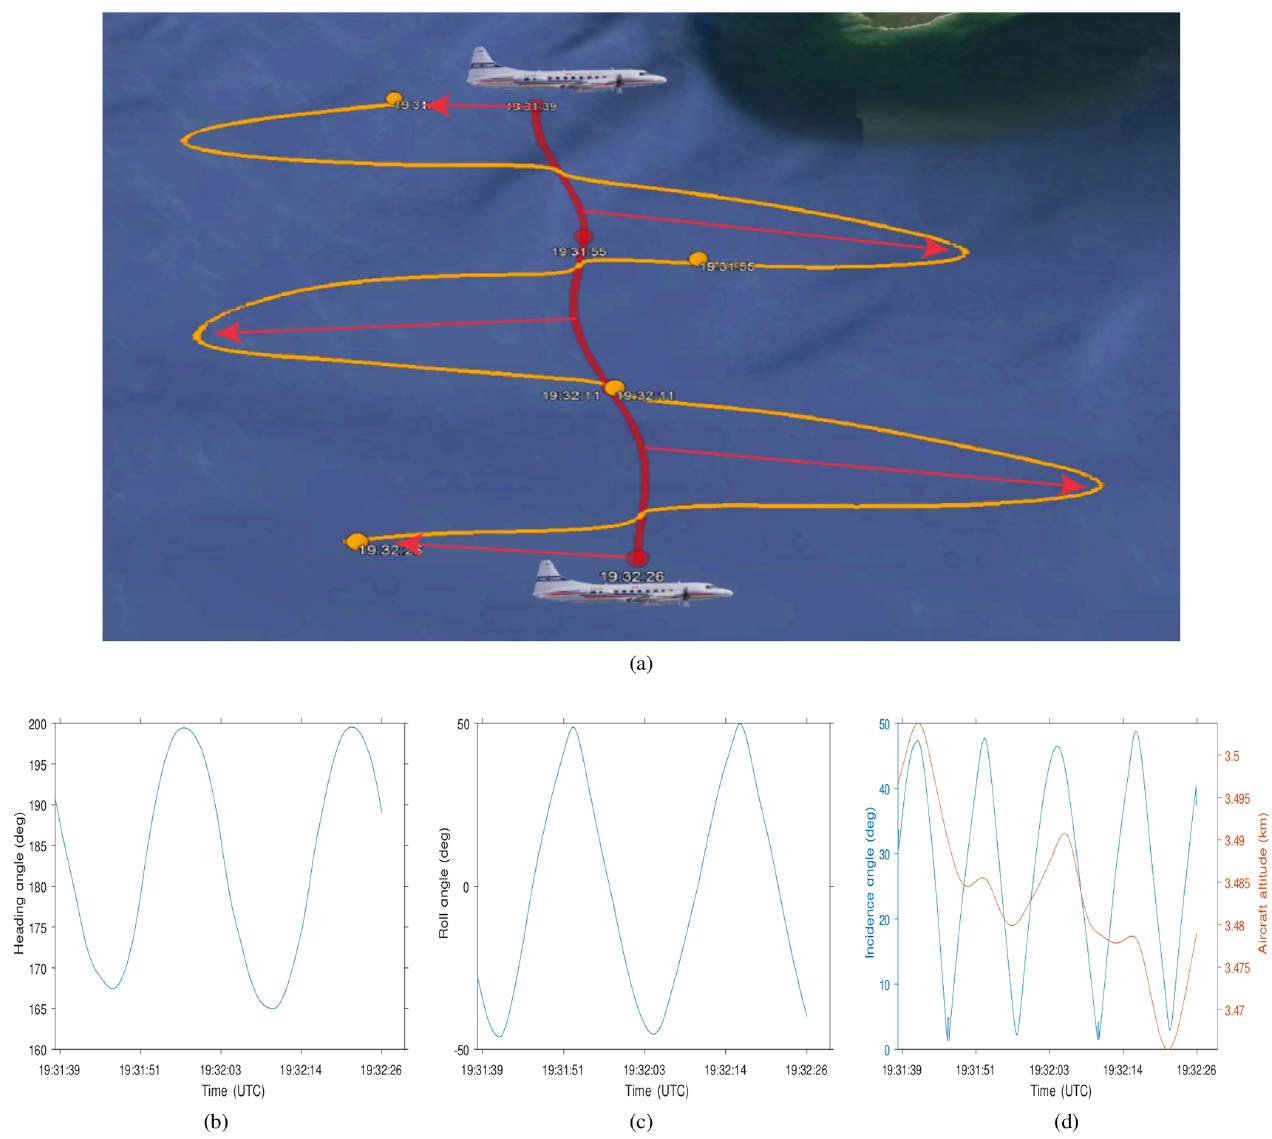
Figure 6. Example of beam angle from aft antenna redirected to nadir by the reflector and the aircraft performing a roll sweep from ∼ ± 45 ◦ over Lake Ontario on 27 January